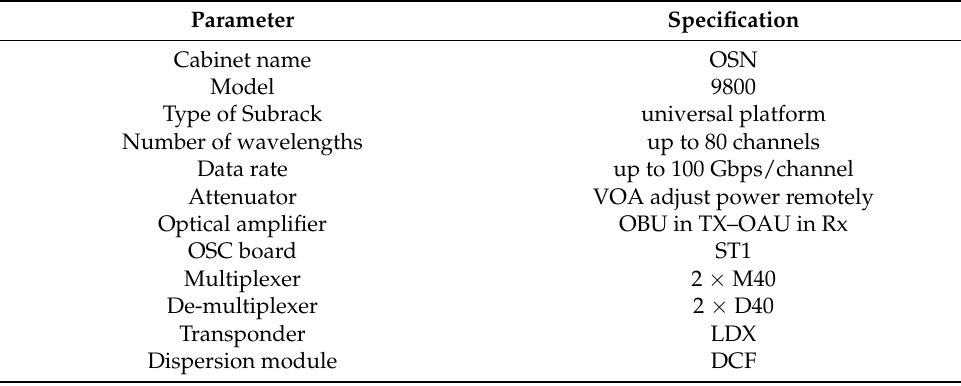
Table 1. The specifications of the implemented DWDM system.